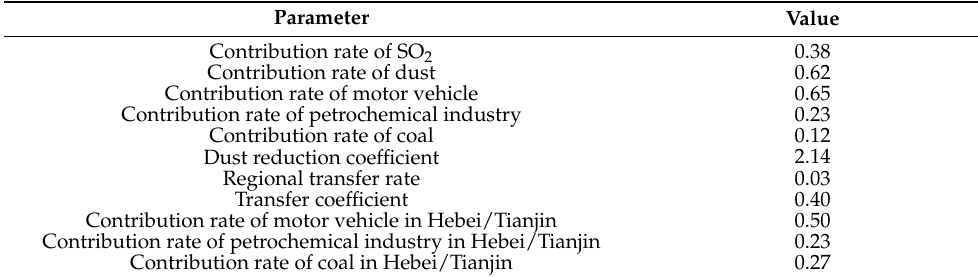
Table 2. The parameters of Beijing urban haze system model.